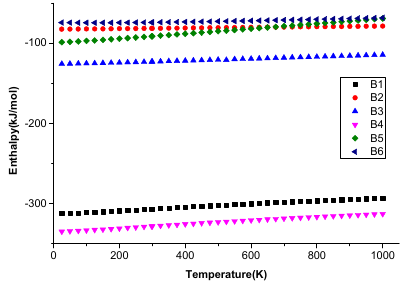
Figure 11. The energy changes of reactions with temperature.